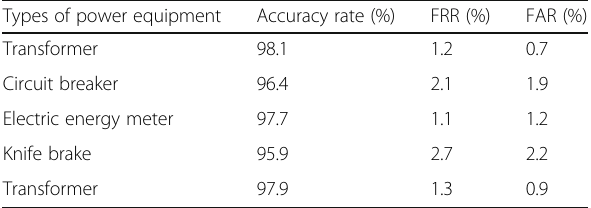
Table 2 Identification and analysis of five types of electric power